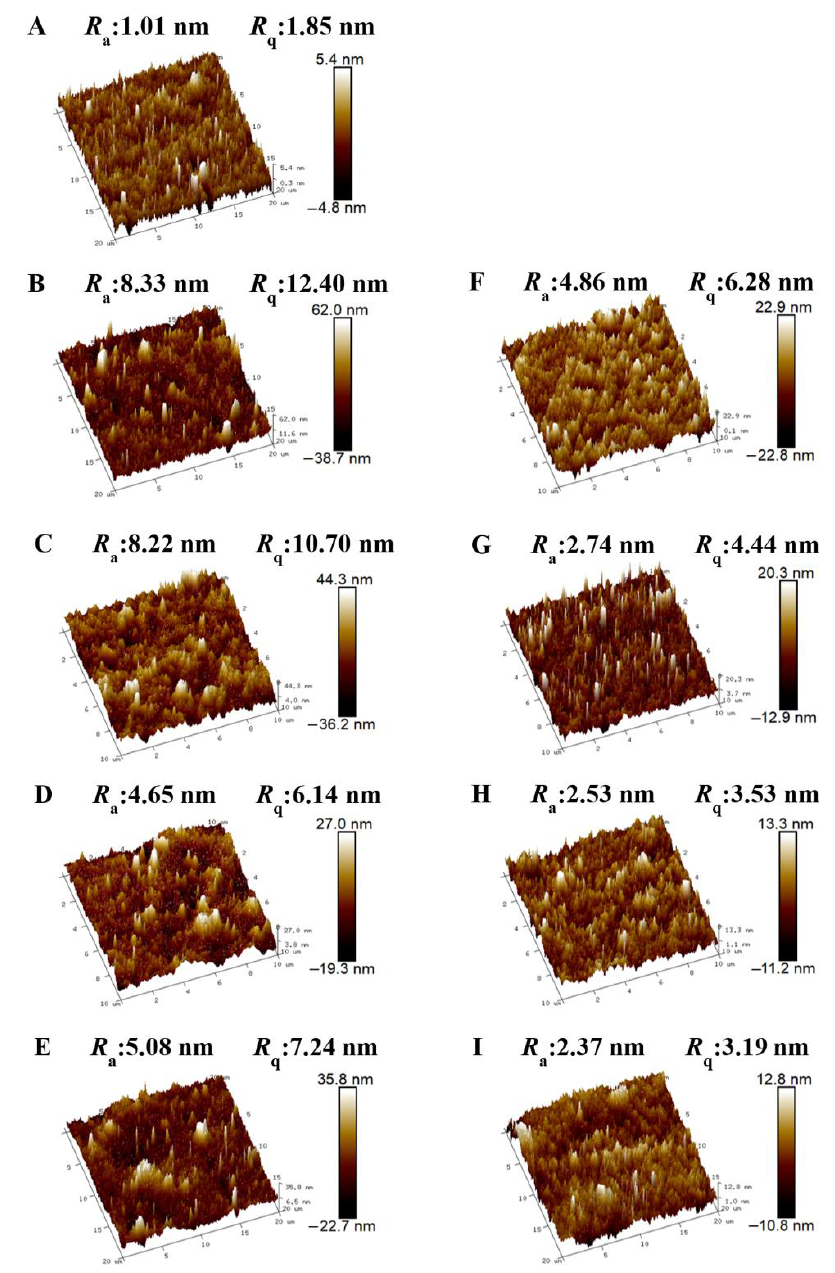
Figure 4. AFM 3D images, average roughness ( R a ), and root-mean-square roughness ( R q ) of different monolayer and bilayer films (( A ): CS, ( B ): L200, ( C ): L201Y, ( D ): H183, ( E ): H182, ( F ): CS-L200, ( G ): CS-L201Y, ( H ): CS-H183, ( I ): CS-H182).